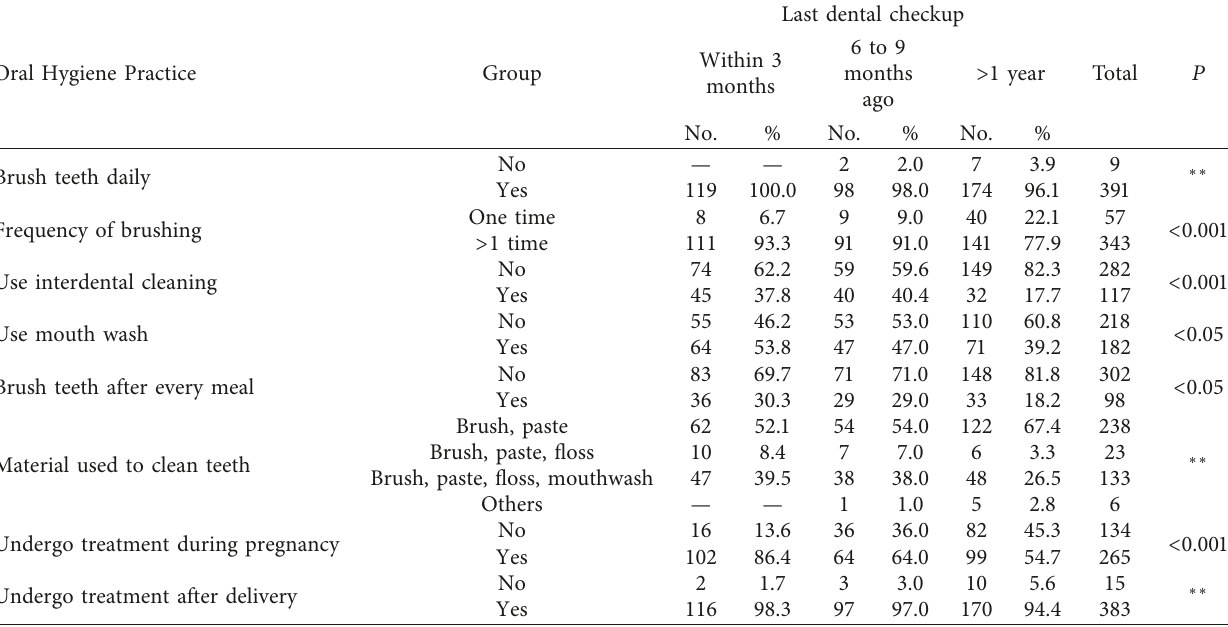
Table 2: Association between oral hygiene practice and knowledge of oral hygiene practices during pregnancy ( N � 400). Oral hygiene